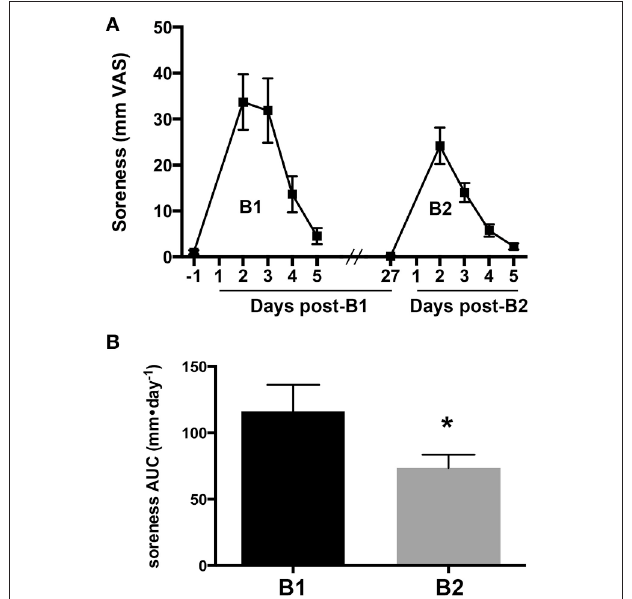
FIGURE 1 | Delayed onset muscle soreness as an indirect marker of muscle damage. (A) Soreness response curves measured on a visual analog scale (VAS) for 1 day before and 5 days following the first (B1) and second bouts (B2) of lengthening contractions (LC). (B) The area under the curve (AUC) for muscle soreness for B1 and B2. * Indicates significant difference (paired t -test, p < 0.05 ).